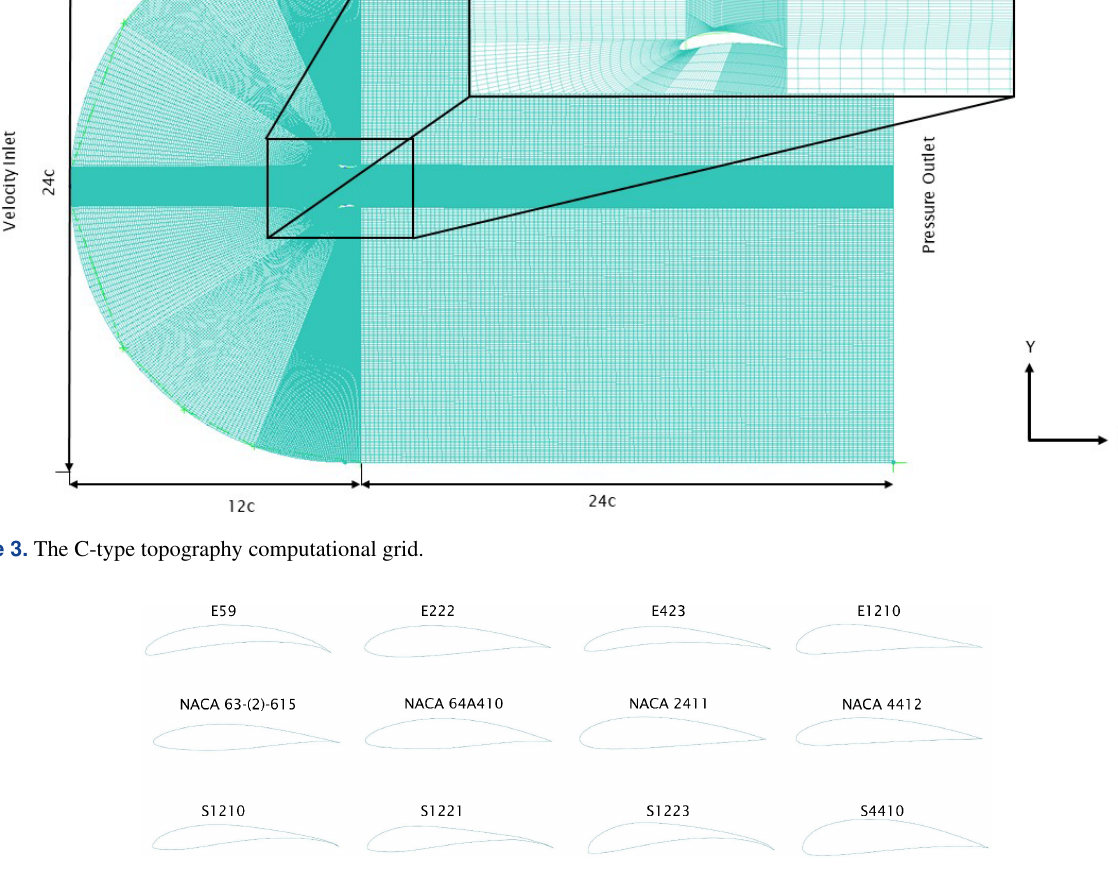
Figure 4. Selection of high-lift airfoils across different